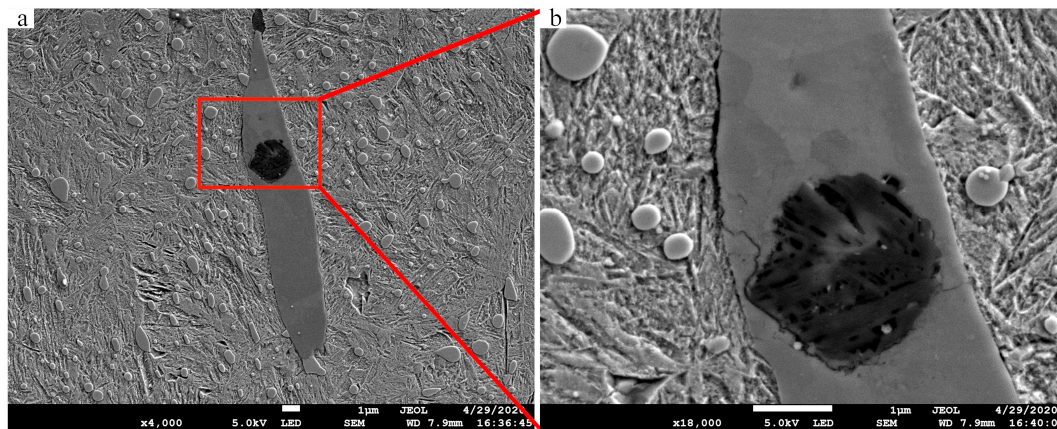
Figure 12. Internal crack of MnS inclusion in 0.3mm section of plate specimen. ( a ) 07# inclusion; ( b ) internal crack inside the 07# inclusion. Position of the inclusion is shown in Figure 10.